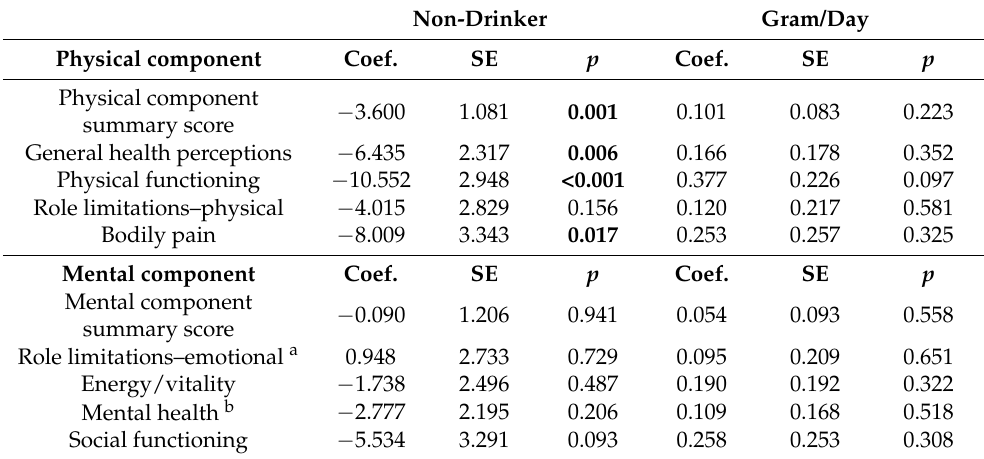
Table 3. Results of the multivariable fractional polynomial regression analyses for the predictors Non-Drinker (drinking status) and Gram/Day (average daily consumption) for the physical and mental component of the VR-12 and their respective